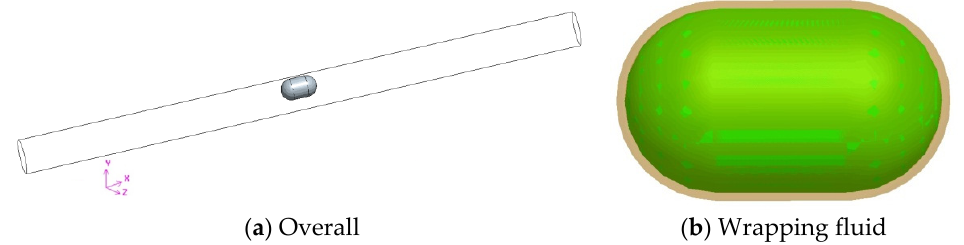
Figure 2. Geometric model of the robot system ( d = 18 mm).